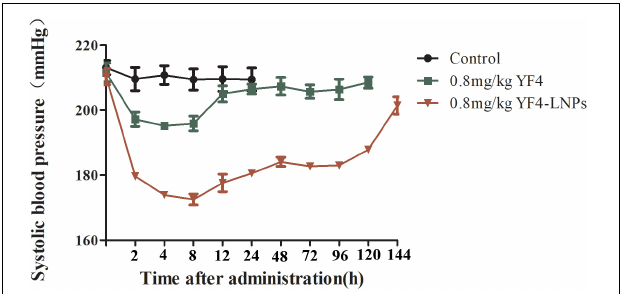
FIGURE 6 | Antihypertensive effects of same doses of YF4and YF4-LNPs in SHRs within 144 h by a single oral